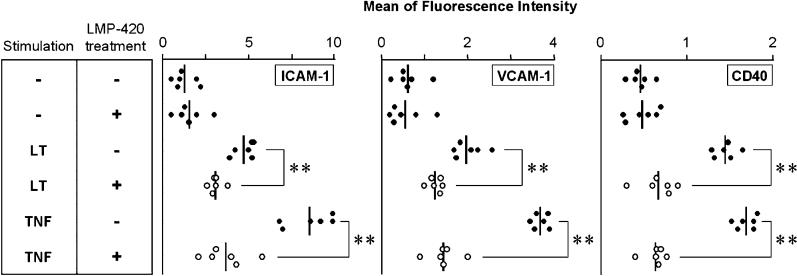
Inhibitory Effect of LMP-420 on TNF-Induced Up-Regulation of ICAM-1 and VCAM-1HBEC-5i were left unstimulated or were activated with LMP-420 alone, TNF alone, TNF with LMP-420, LT alone, or LT with LMP-420. After an overnight incubation, cells were detached and analyzed by flow cytometry after immunolabeling for ICAM-1, VCAM-1, and CD40. Results are expressed as dotplots of mean fluorescence intensity of surface expression of the antigens measured in six experiments (Dunn's test, ** corresponds to p < 0.01).